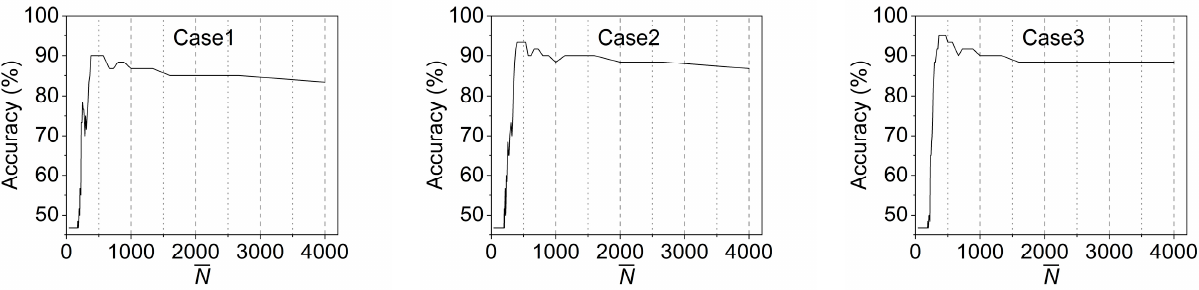
Figure 17. Pooling performance with different data size.